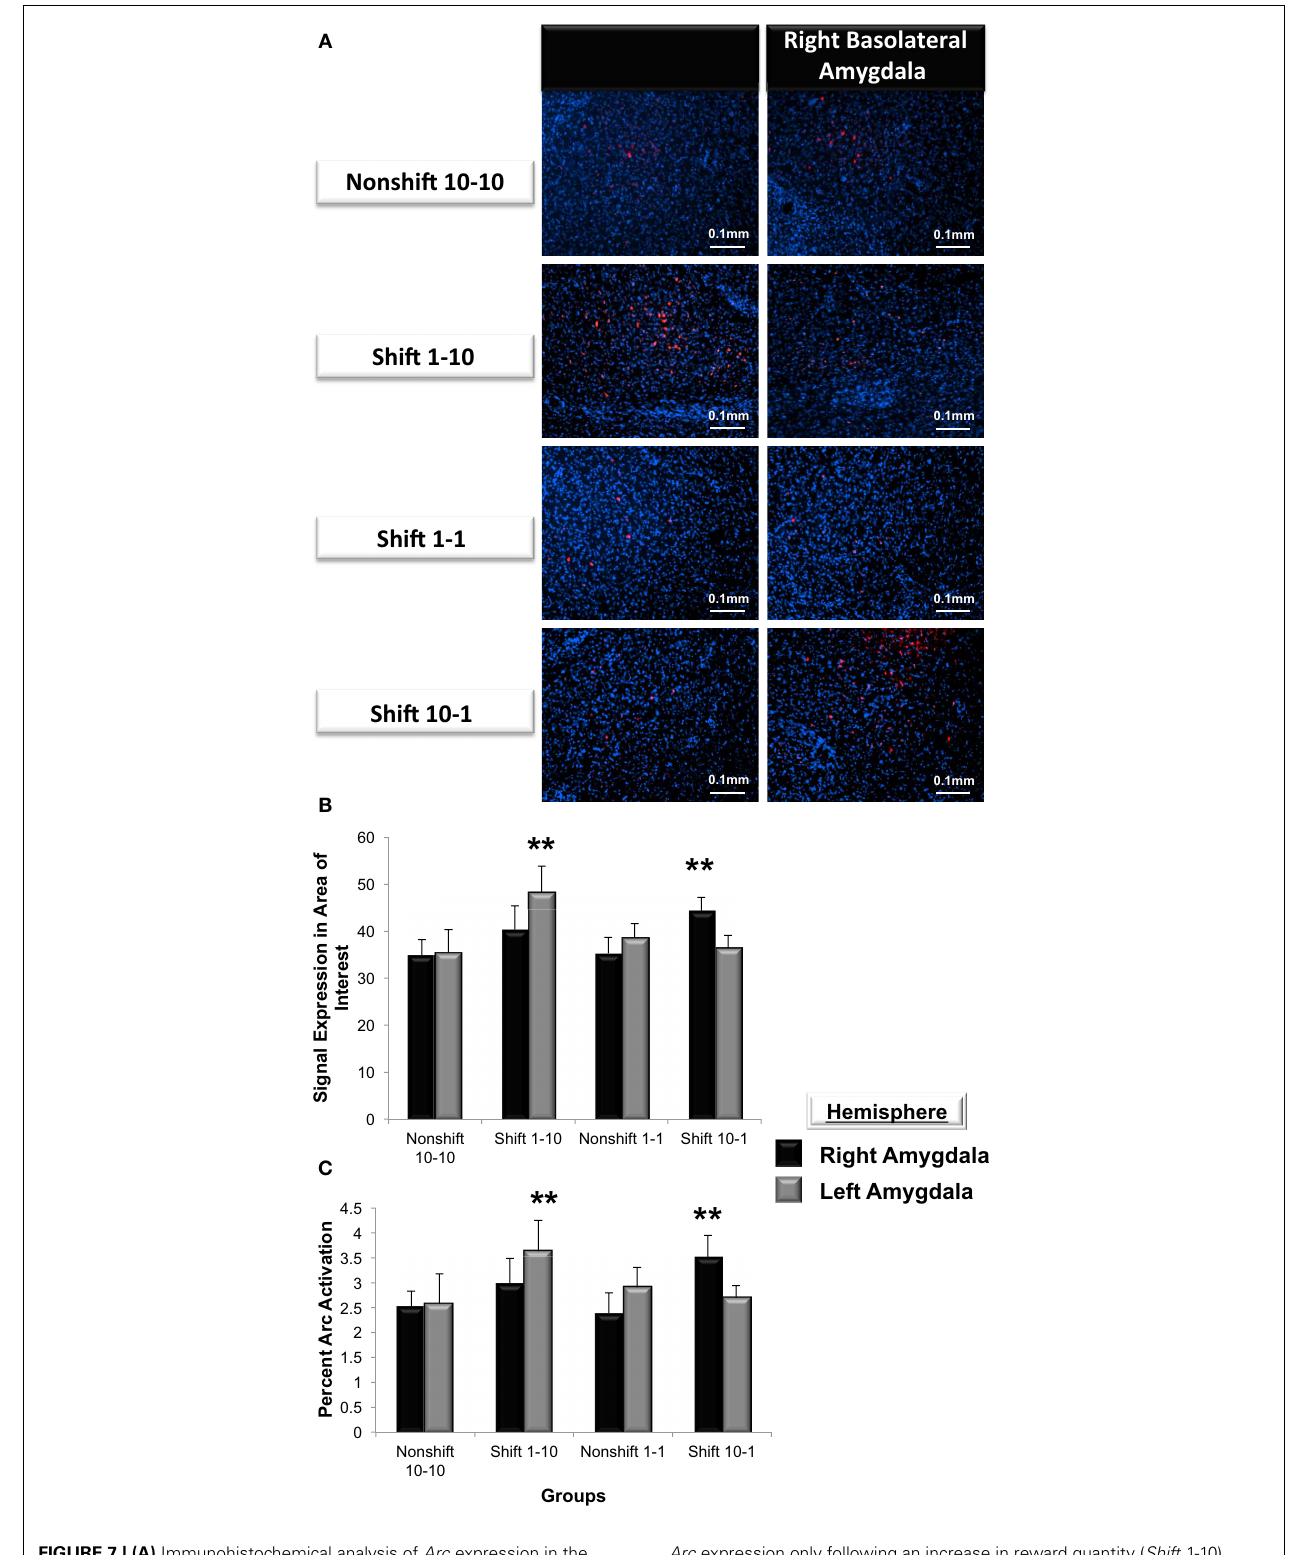
Arc expression only following an increase in reward quantity ( Shift 1-10), whereas right basolateral Arc expression was elevated only by the unexpected reduction in reward quantity after the FR-5 ( Shift 10-1). (B) Mean